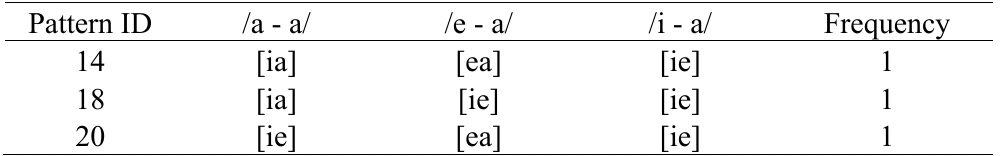
Table 8 . Attested but underived